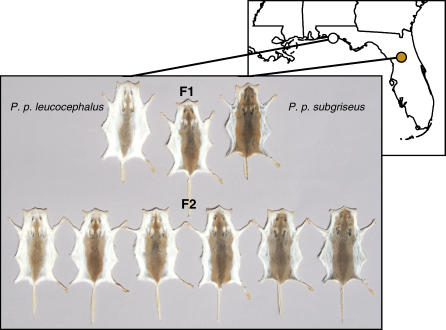
Pigmentation Patterns of a Beach Mouse (P. polionotus leucocephalus), a Mainland Mouse (P. p. subgriseus), the Resulting Hybrid (F1), and the Second-Generation Reciprocal-Intercross Progeny (F2)The parental strains were from Santa Rosa Island, Florida, United States (white circle) and Ocala National Forest, Florida, United States (brown circle). Based on quantitative measurements, parental subspecies differ significantly in seven pigmentation traits (Student's t-test, p < 0.001). For some traits, F1 hybrids are intermediate between the parental phenotypes (e.g., earbase pigmentation), while for others they are more similar to either the beach parents (e.g., lack of a tail stripe) or to mainland parents (e.g., extent of dorsal pigmentation), suggesting variation in the degree of additivity and dominance of alleles contributing to the light phenotype. The F2 progeny show continuous phenotypic variation in pigmentation patterns, consistent with a multigenic basis of patterning variation. However, parental phenotypes are recovered in the F2 progeny, suggesting that differences in pigmentation are controlled by a small number of genes.